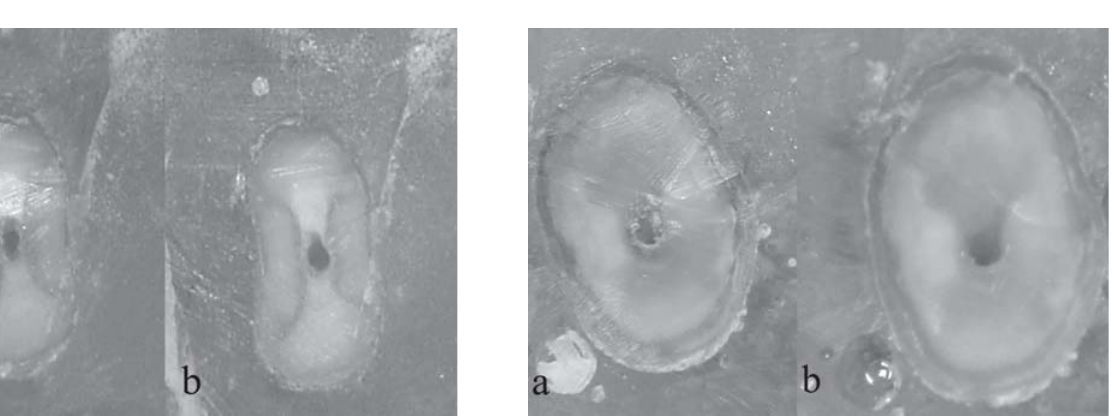
FIGURE 5- Apical third before (a) and after (b) preparation with Endo-Eze system (Score